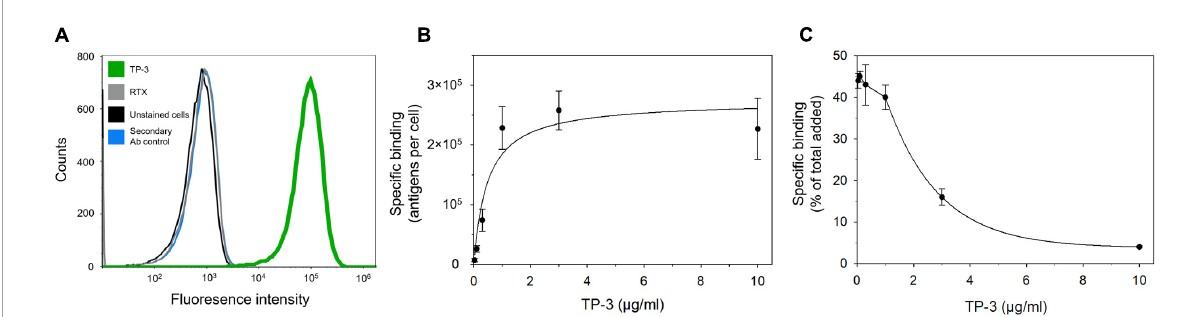
FIGURE1 p80 expression and specific binding of TP-3 to OHS human osteosarcoma cells. (A) A flow cytometry histogram that demonstrates the binding of TP-3 to the p80 antigen (green curve), compared to the non-specific primary antibody rituximab (RTX; gray curve), OHS cells stained only with the secondary antibody (blue curve) or unstained control cells (black curve). (B) Specific binding (antigens per cell) and (C) percentage specific bound TP-3 (of total added) to OHS cells after 1 h incubation with 0.03–10 µ g/ml of 212 Pb-TCMC-TP-3.